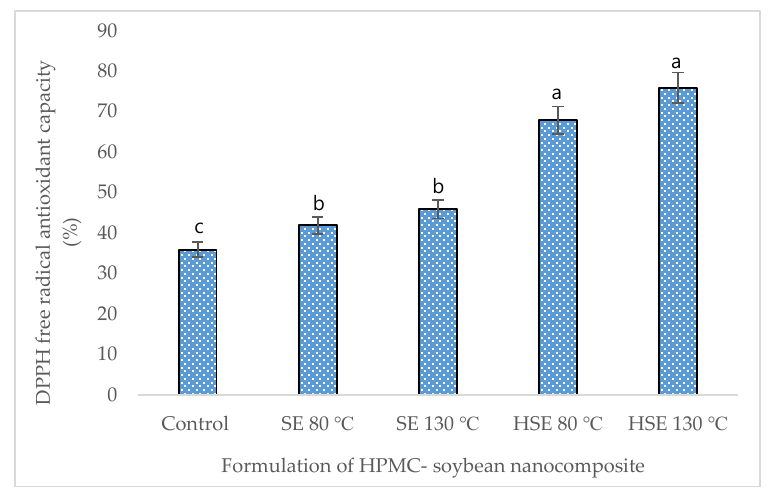
Figure 3. DPPH (2,2-diphenyl-1 picryl hydrazyl) free radical scavenging activity of the soybean composite. Mean values ± SD from triplicate separated experiments are shown. Control: non-extrudate soybean, SE: extrudate 100% soybean at a different temperature, HSE: soybean (95%) + HPMC (5%) extrudate at a different temperature. Foods 2019 , 8 , x FOR PEER REVIEW